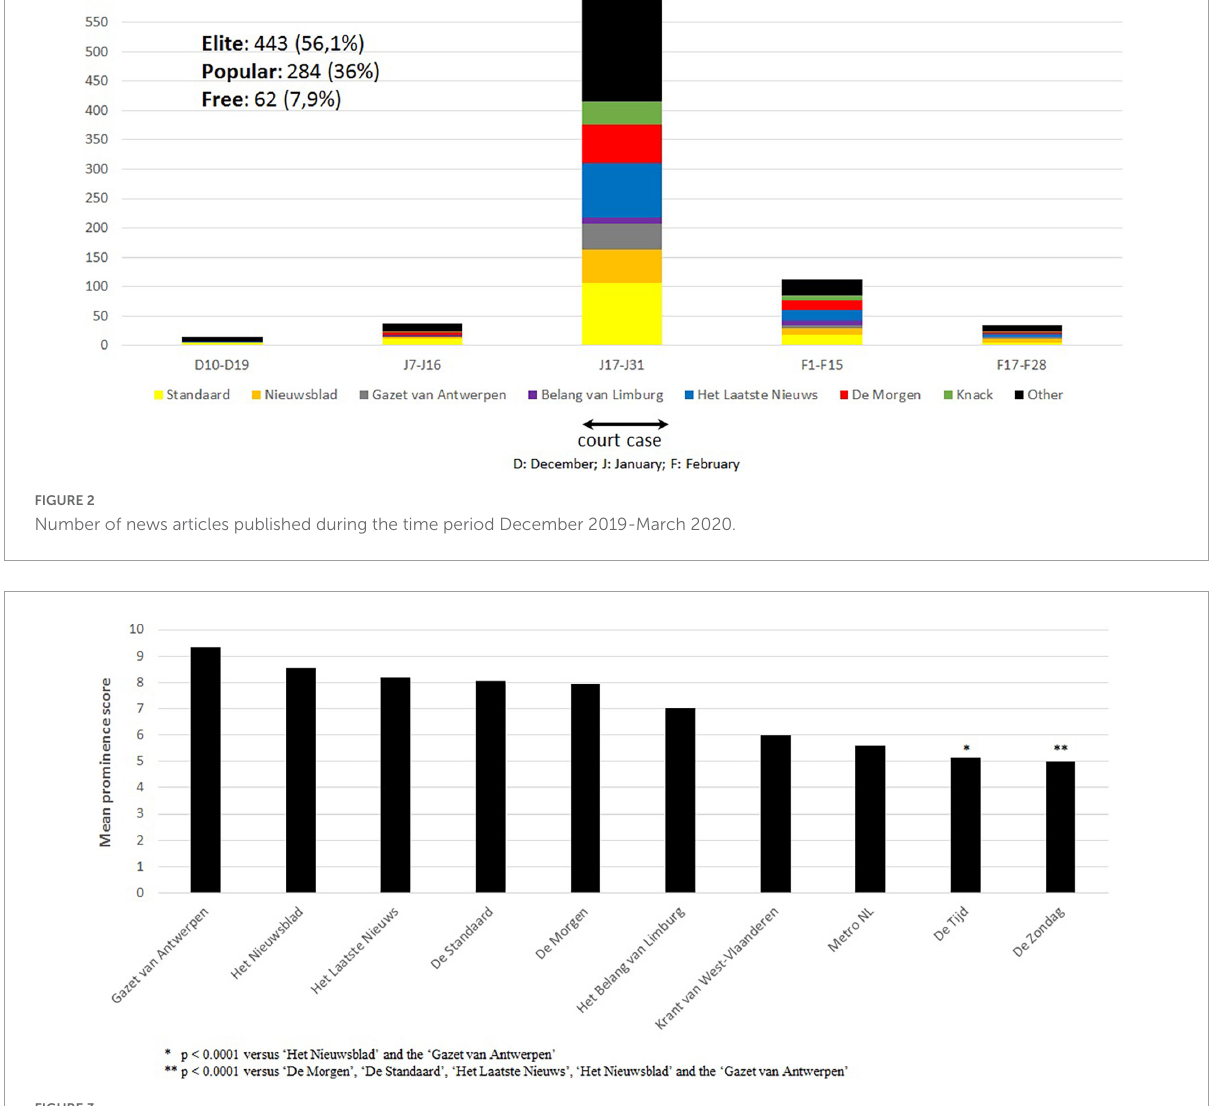
FIGURE3 Mean prominence score per